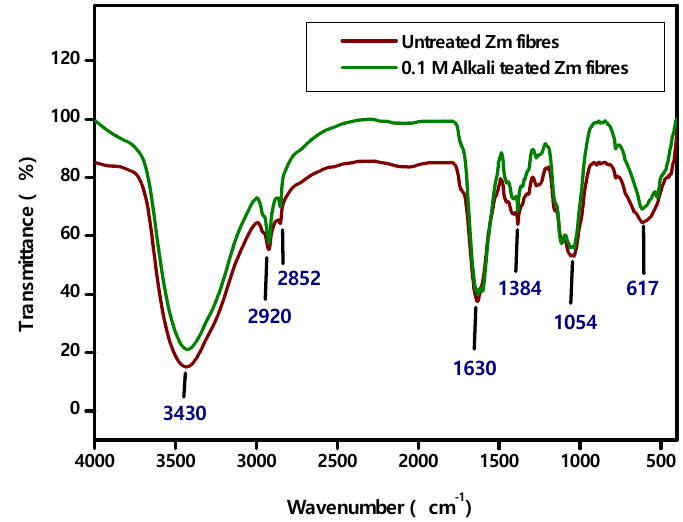
Figure 5. FTIR Spectra of raw and alkali treated Zm fibres.